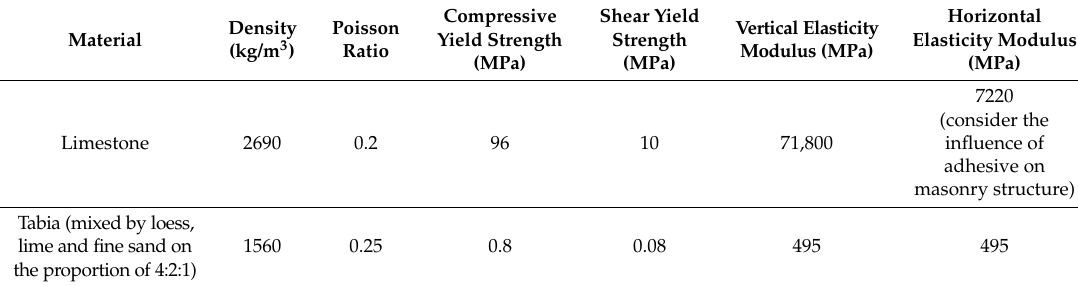
Table 2. Material parameters of the Limestone